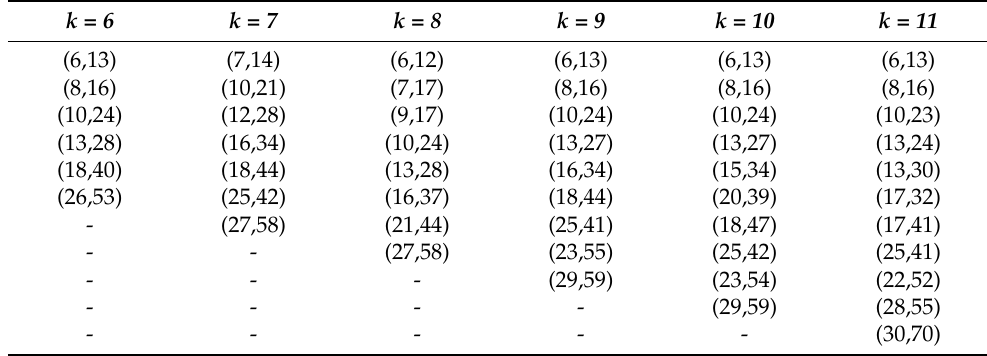
Table 5. A priori aspect ratio corresponding to different k